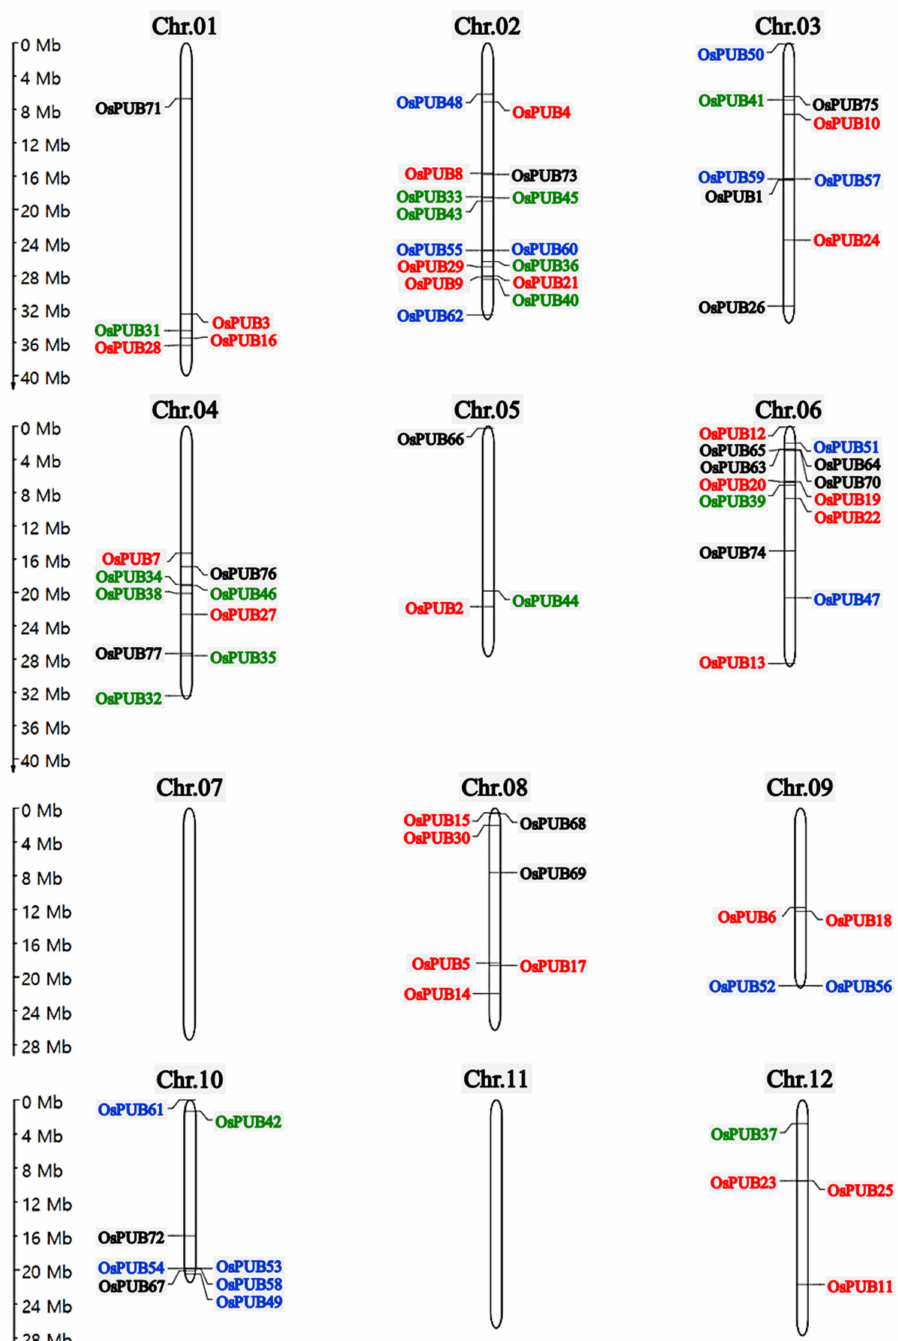
Figure 1. Chromosome mapping of U-box E3 ubiquitin ligase gene family in Oryza sativa . The rice U-box gene family is divided into different classes shown by different colors: red color, Class 2; green color, Class 3; blue color, Class 4; black color, Class 1, Class 5, Class 6, Class 7, and Class 8. Chromosome number is shown at the top of the bar. The scale bar on the left indicates chromosome length